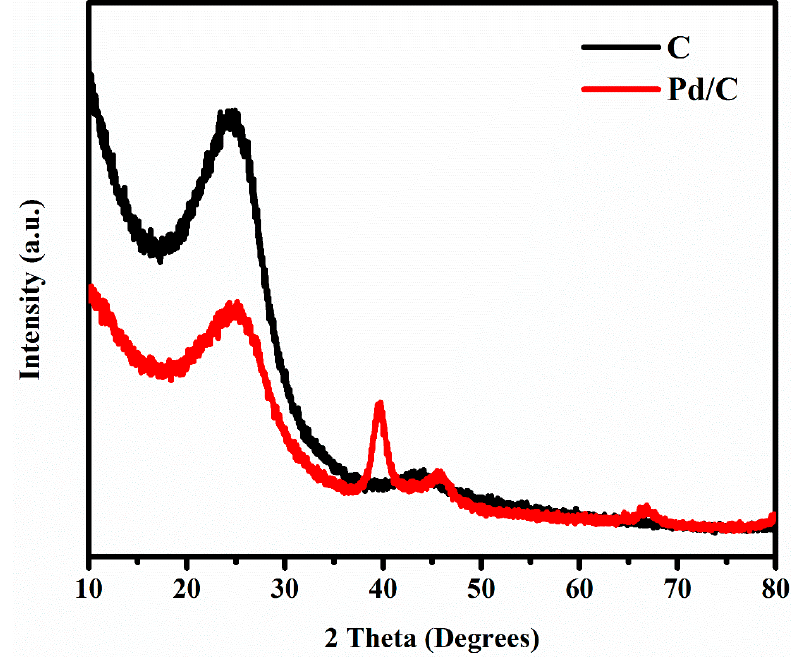
Figure 5. XRD results of CNFs and Pd/CNFs.